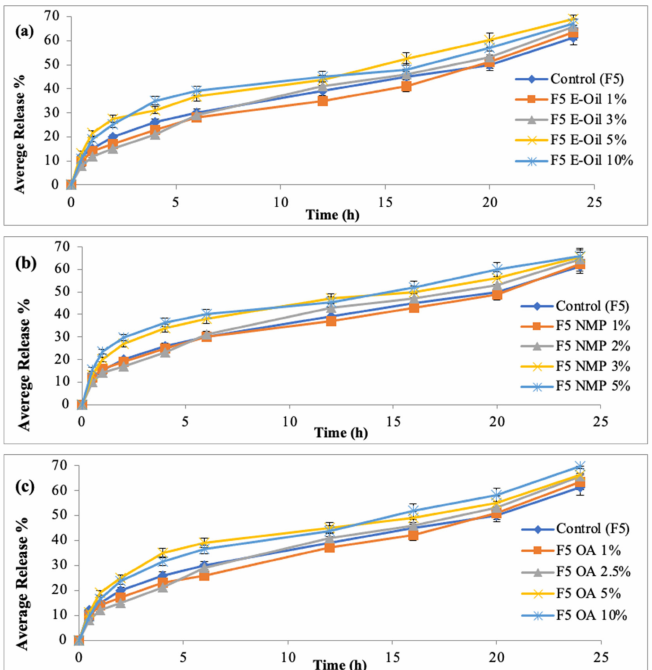
Figure 8. Release profiles of methotrexate from formulated patches using ( a ) EO, ( b ) NMP and ( c ) OA as penetration enhancers. Data are expressed as mean ± SD; n = 3. One-way ANOVA followed by post hoc Tukey test ( p >